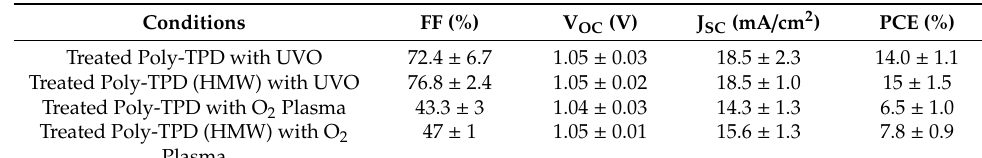
Figure 8. AFM images (5 × 5 μ m) of the treated Poly-TPD (Rq = 1.79 nm) ( a ), the treated Poly-TPD (HMW) (Rq = 2.00 nm) ( b ), the treated Poly-TPD with Oxygen plasma (Rq = 1.72 nm) ( c ), and the treated Poly-TPD (HMW) with Oxygen plasma (Rq = 1.86 nm) ( d ). Devices with the architecture Glass/ITO/treated Poly-TPD (HMW and LMW)/Perovskite: Starch/PCBM/BCP/Al, as described in the experimental section, were made. The average measured photovoltaic parameters and the current-voltage curves related to perovskite solar cells constructed by the Poly-TPD at different MWs treated by UVO and Oxygen plasma is shown in Table 2, while the IV curve of the champion device is shown in Figure 9. At best, the photovoltaic parameters of this device are as follows: J SC = 19.9 mA/cm 2 , V OC = 1.05 V, FF = 78%, and PCE of 16.34%, with respect to Table 2. The average measured photovoltaic parameters for inverted planar perovskite solar cell with Poly-TPD (HMW) under AM1.5G illumination (~100 mW cm 2 ).